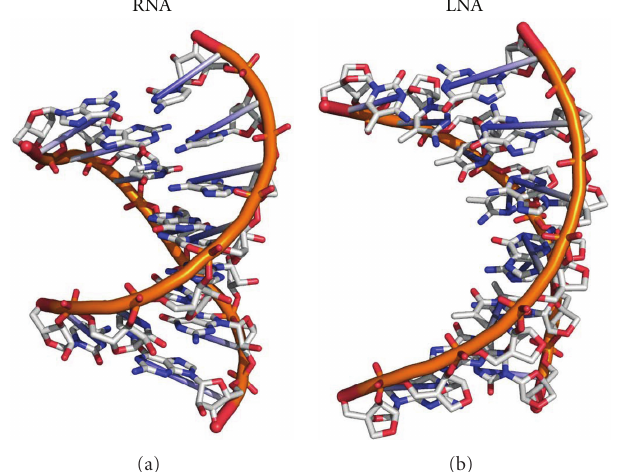
Figure 2: Crystal structure of the RNA duplex r[GGUGAGG] · r[CCUCACC] (PDB ID: 3GVN) as compared to the corresponding LNA helix (PDB ID: 2X2Y).